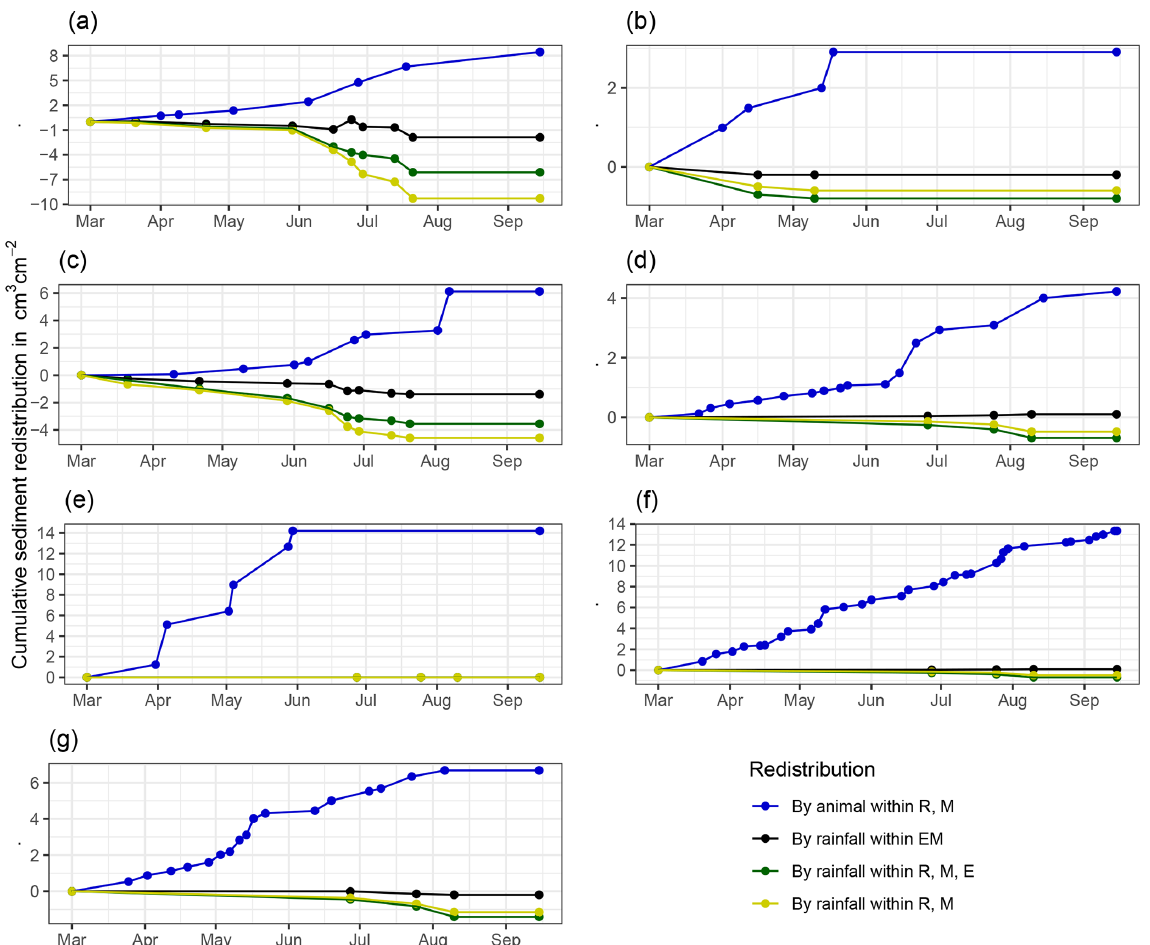
Figure A7. Cumulative volume of redistributed sediment for all cameras. Positive values indicate sediment accumulation. Negative values indicate sediment erosion. Whiskers are the median sediment redistribution. E is the burrow entrance. M is the mound. R is the burrow roof. EM is the burrow-embedded area. LC is the Mediterranean climate zone. PdA is the arid climate zone: (a) LC-NU, (b) LC-SU, (c)